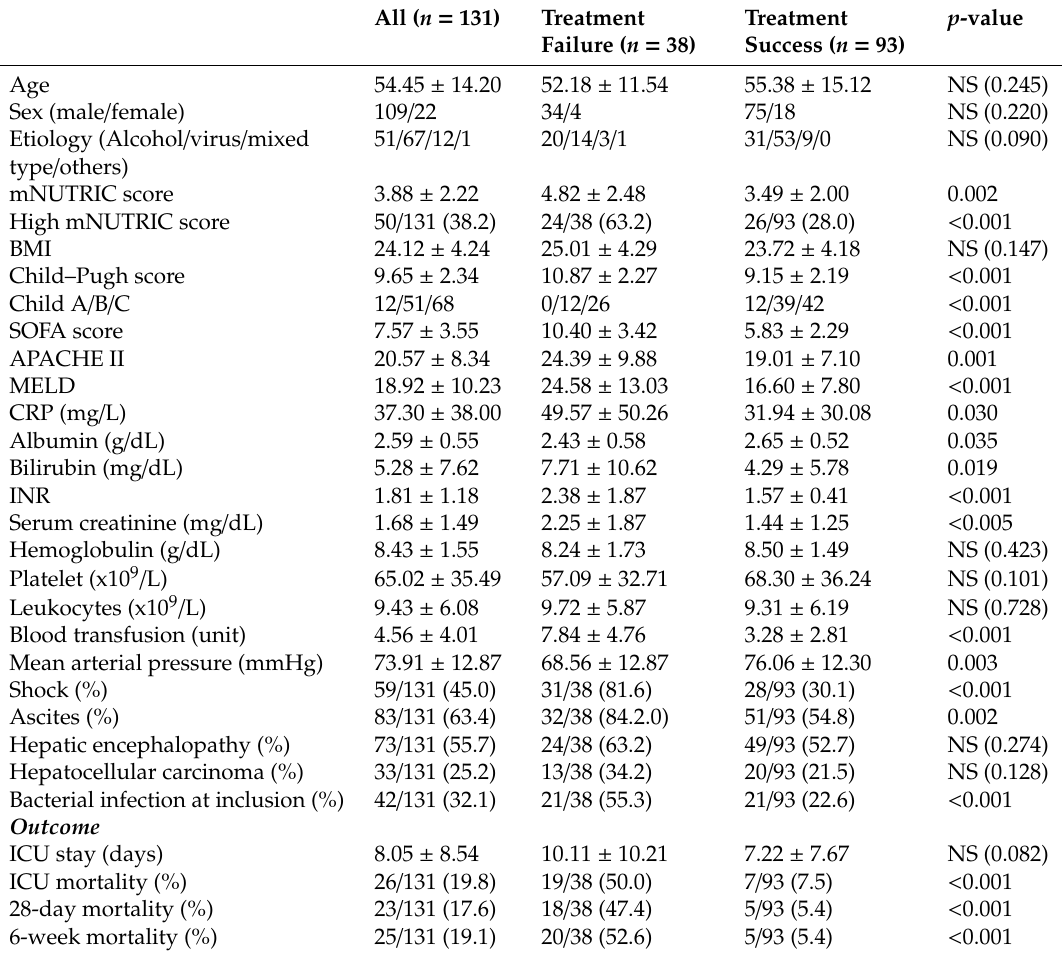
Table 4. Patients’ demographic data and clinical characteristics at admission to ICU grouped according to treatment